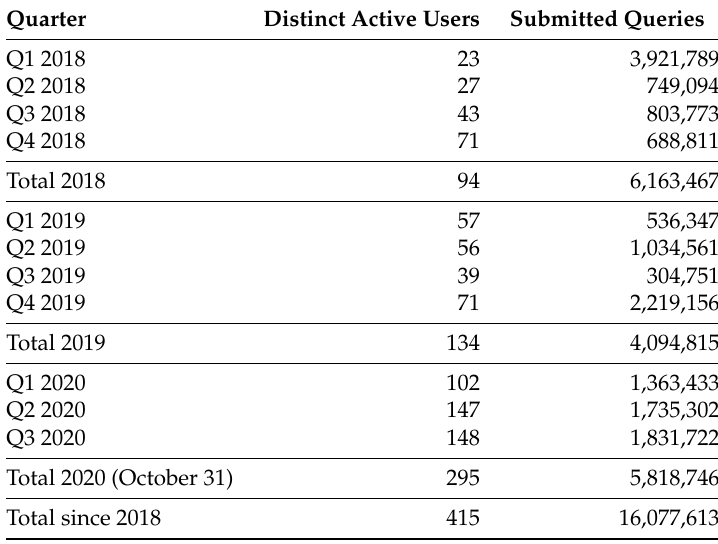
Table 1. Usage of OpenSky’s historical Impala database over